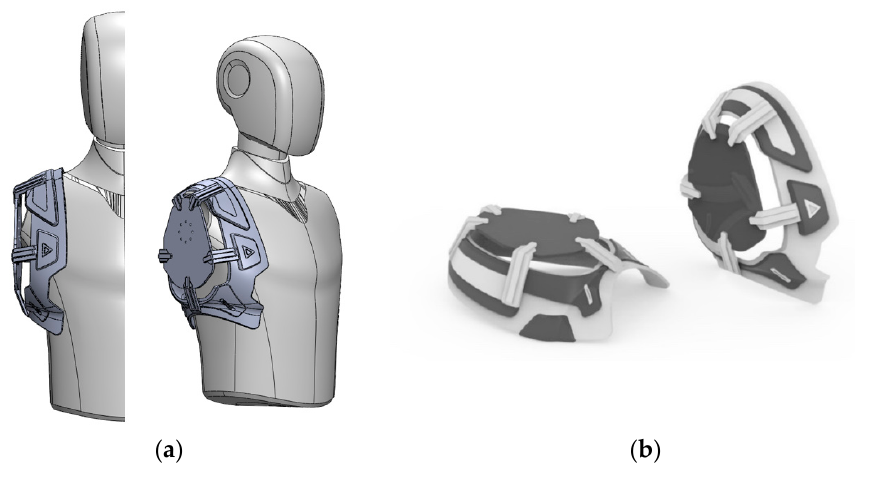
Figure 1. The proposed rigid support of the fabric vest socket. ( a ) three-dimensional (3D) computer- aided design (CAD); and ( b ) rendering design.